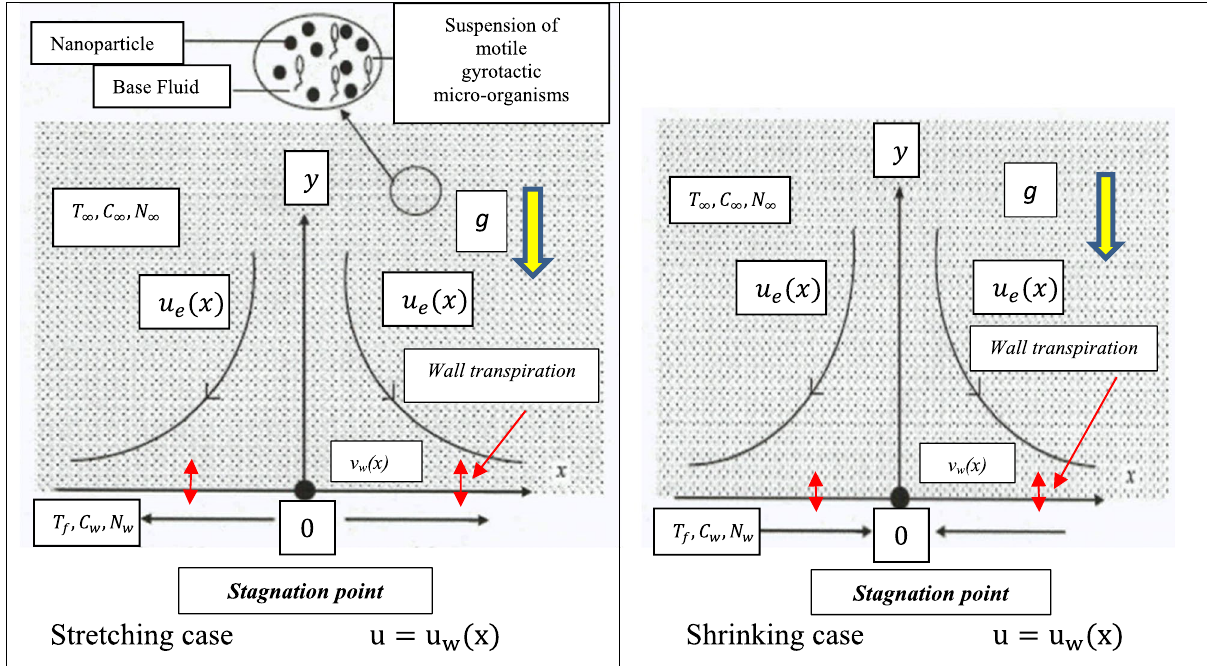
Figure 1. Physical model and coordinate system for stagnation stretching/shrinking bio-nanocoating